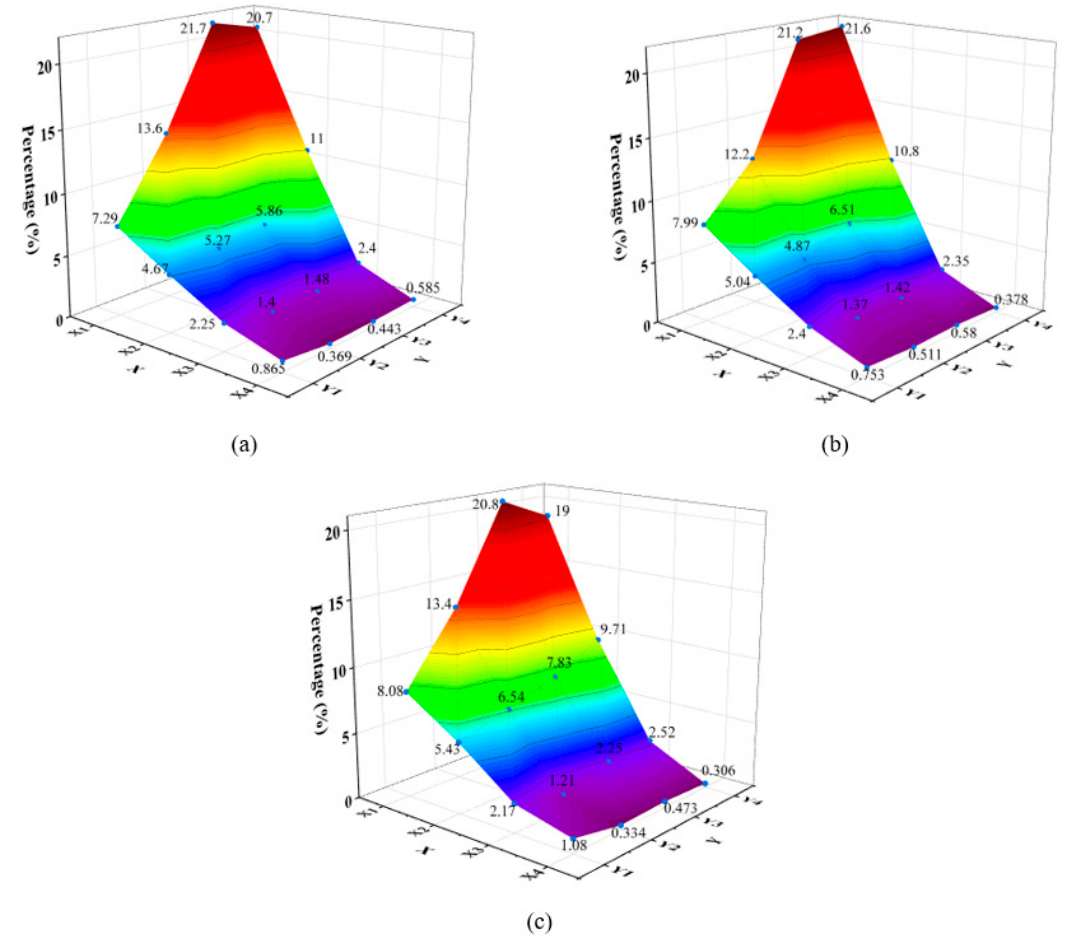
Figure 13. Percentage quantity distributions of the threshed output mixture in reception boxes: ( a ) single threshing gap of 15 mm; ( b ) single threshing gap of 10 mm; ( c ) multi-threshing gaps of 10 mm and 15 mm.